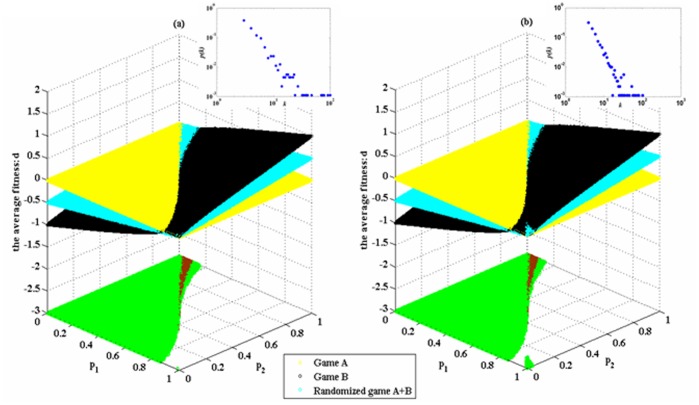
The influence of the average degree of the nodes on the Parrondo effect (based on the BA scale-free network).The population size N is 900 and the average number of playing times T of each individual is 100. The probability of playing game A is p = 0.5. Repeatedly play the games 30 times with different random numbers, and draw the corresponding figures according to the average results of the games. The small window in the figure shows the degree distribution of the nodes. The green area in the figure represents the weak-paradox area, whereas the brown region denotes the strong area. The average degree of the network in Figure 8 (a) and Figure 8 (b) is 5.9867 and 7.9756, respectively.